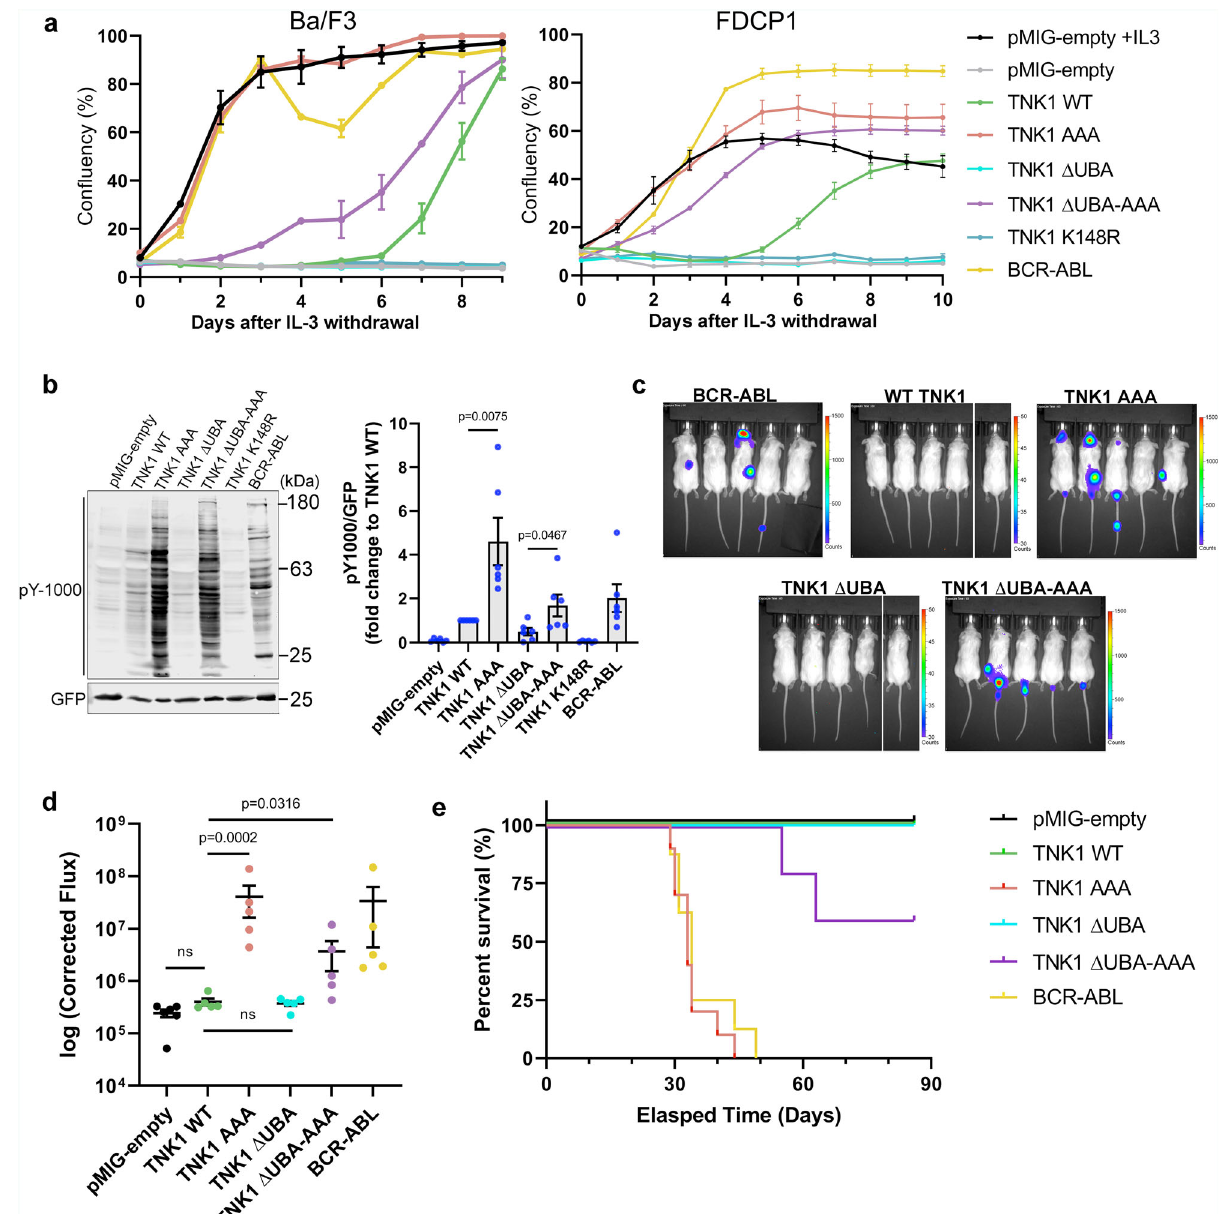
Fig. 4 Full activation of TNK1 requires release from 14-3-3 and interactions between the TNK1 UBA and ubiquitin. a Ba/F3 or FDCP1 cells were transduced and analyzed as in Fig. 3, with either pMIG-empty vector, TNK1 (WT or indicated mutants), or BCR-ABL. IL-3 independent growth was monitored as in Fig. 3g. The graph shows average cell con fl uency with error bars representing SEM from 3 biological replicates. b Ba/F3 cells from panel a were immunoblotted for global phospho-tyrosine and GFP (expressed from virus). Graphs show average global tyrosine phosphorylation quantitation from multiple biological replicates ( n = 6) with signals normalized to WT. Error bars represent SEM. P-values were calculated using a two-tailed student t -test. c 1×10 6 Ba/ F3-luc cells transduced with WT TNK1 or the indicated TNK1 mutants were injected into the tail vein of NOD/SCID mice ( n = 5). Luminescent signal was imaged and quanti fi ed using IVIS imaging and ROI analysis. Images shown are mice in prone position 28 days after injection. d Corrected Flux (raw luminescent signal minus background luminescent signal) of mice from panel c. The box plot shows the median, fi rst and third quartile of corrected fl ux ( n = 5). P -values were calculated using a two-tailed student t -test. e Survival plot of mice from panel c ( n = 5). Source data are provided as a Source Data fi